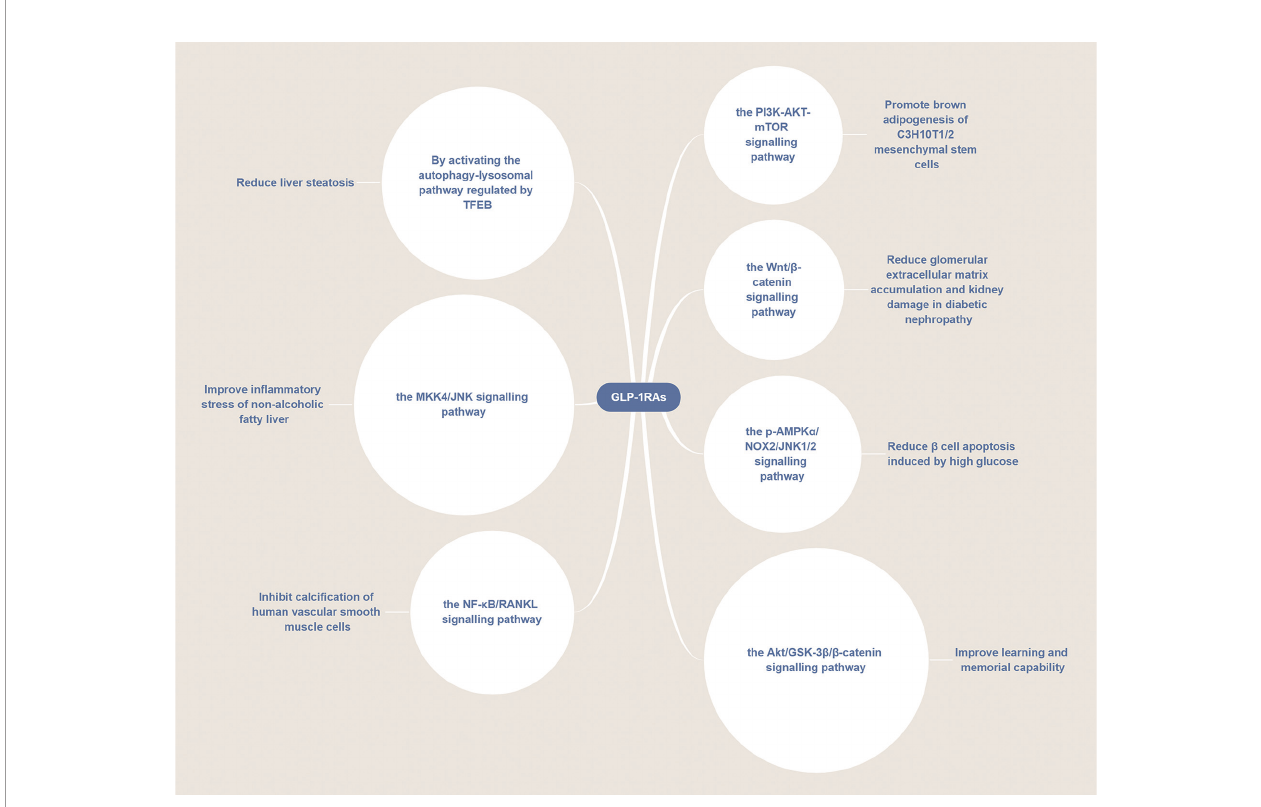
FIGURE 4 | GLP-1RAs are involved in a variety of disease pathways. GLP-1RAs can activate several signaling pathways, such as the PI3K/AKT/mTOR, p-AMPK a / NOX2/JNK1/2, Wnt/ b -catenin, Akt/GSK-3 b / b -catenin, NF- k B/RANKL, and MKK4/JNK pathways thus exerting a therapeutic effect in different